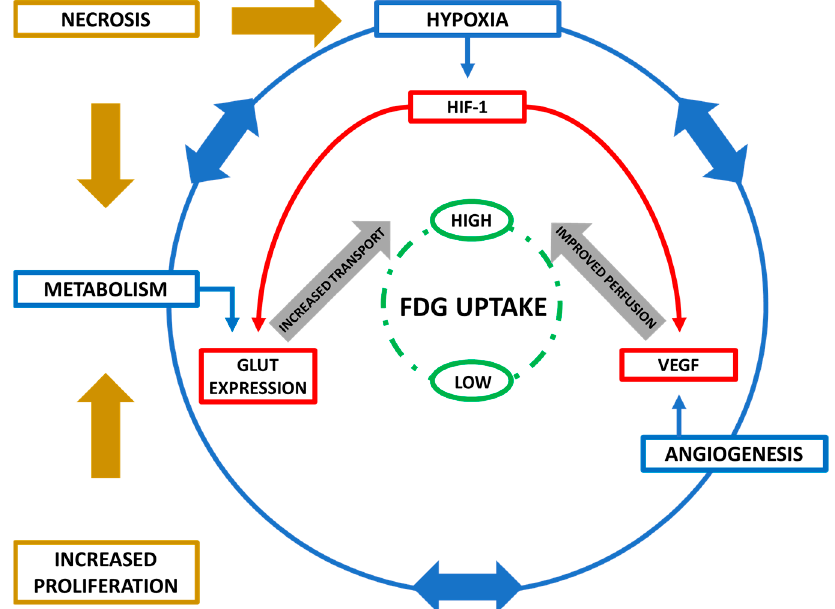
Figure 1. Biomolecular influences on [ 18 F]FDG uptake. Metabolism, hypoxia and angiogenesis all